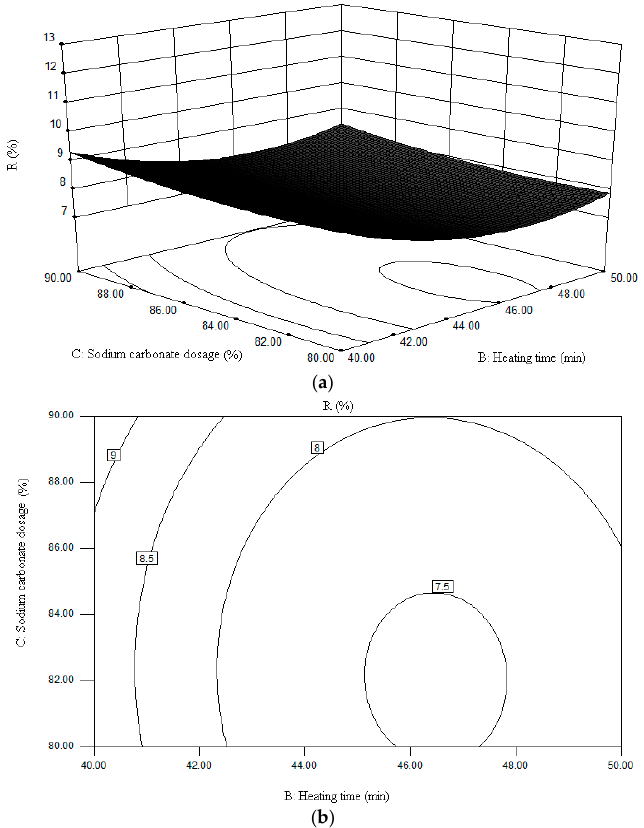
Figure 4. ( a ) Response surfaces of heating time–sodium carbonate dosage plot and ( b ) contour of heating time–sodium carbonate dosage plot.